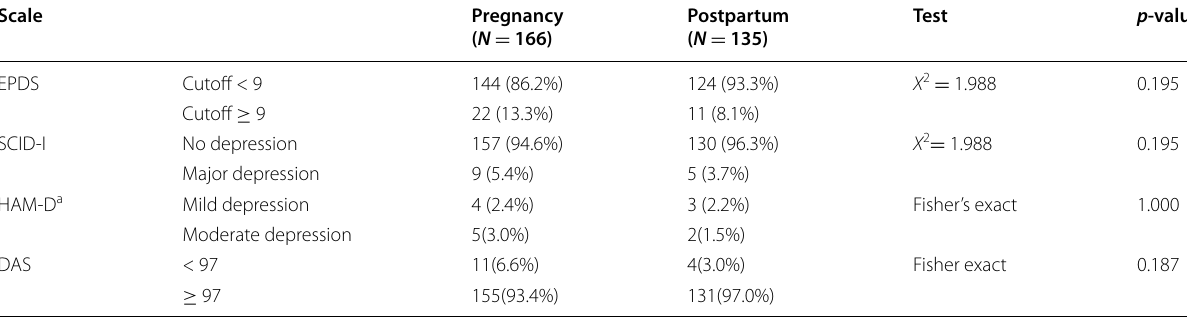
EPDS Edinburgh Postnatal Depression Scale, DAS the Dyadic Adjustment Scale, HAM-D Hamilton Rating Scale for Depression, SCID-I the Structured Clinical Interview for DSM-IV; a total number